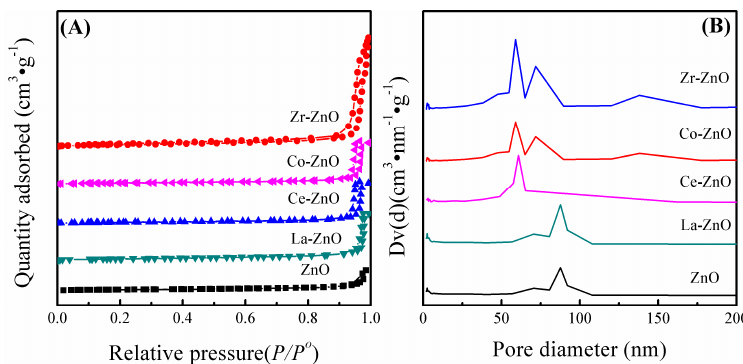
Figure 4. N 2 adsorption–desorption isotherm ( A ) and pore size distribution ( B ) of ZnO catalyst modified by transition metal.